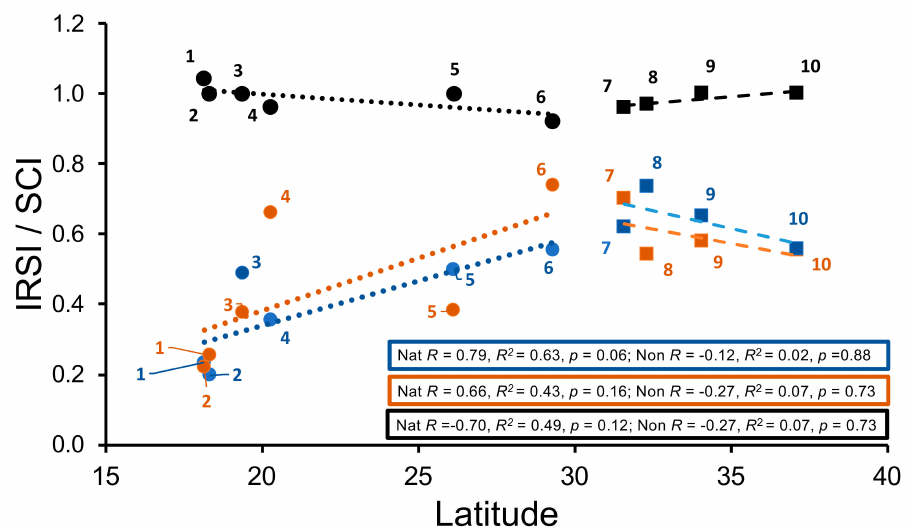
Figure 5. Relationship between self-compatibility index (SCI) (symbols and line black) and the integral reproductive success index (IRSI) of self- (symbols and line blue) and cross-pollination (symbols and line orange) with the latitudinal location of native and non-native populations of Oenothera drummondii . The boxes show the results of linear regression for each index for native (Nat) and non-native (Non) populations. Circles indicate native populations and squares indicate non-native populations. Numbers indicate acronyms of populations described in Figure